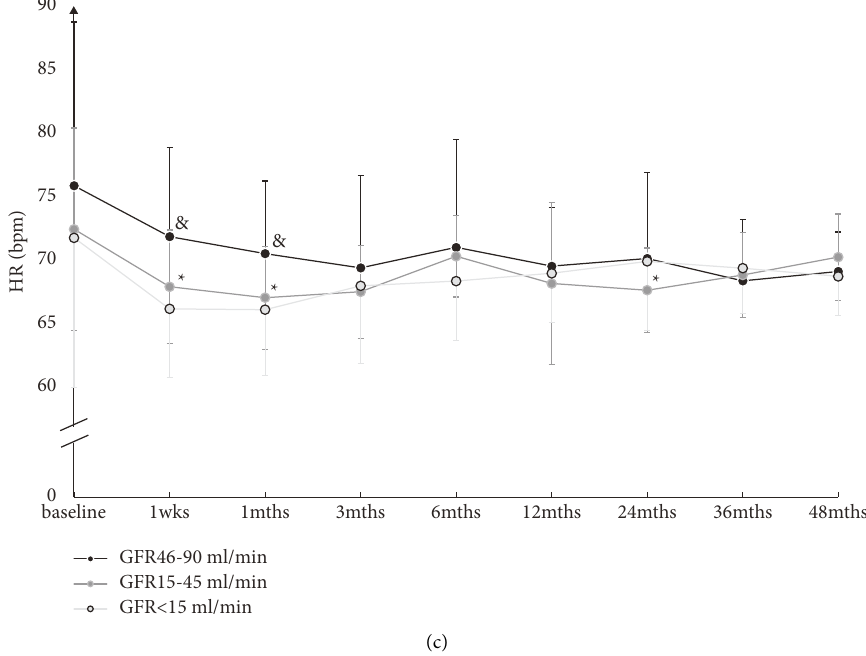
Figure 3: Changes of 24 h ambulatory blood pressure from baseline to 48 months. (a) Change of the systolic blood pressure. (b) Change of diastolic blood pressure. (c) Change of heart rate. SBP: systolic blood pressure; DBP: diastolic blood pressure; HR, heart rate. ∗ P < 0 . 05, compared with baseline. # P < 0 . 05, GFR46-90 ml/min VS GFR < 15ml/min and P < 0 . 05, GFR46-90ml/min VS